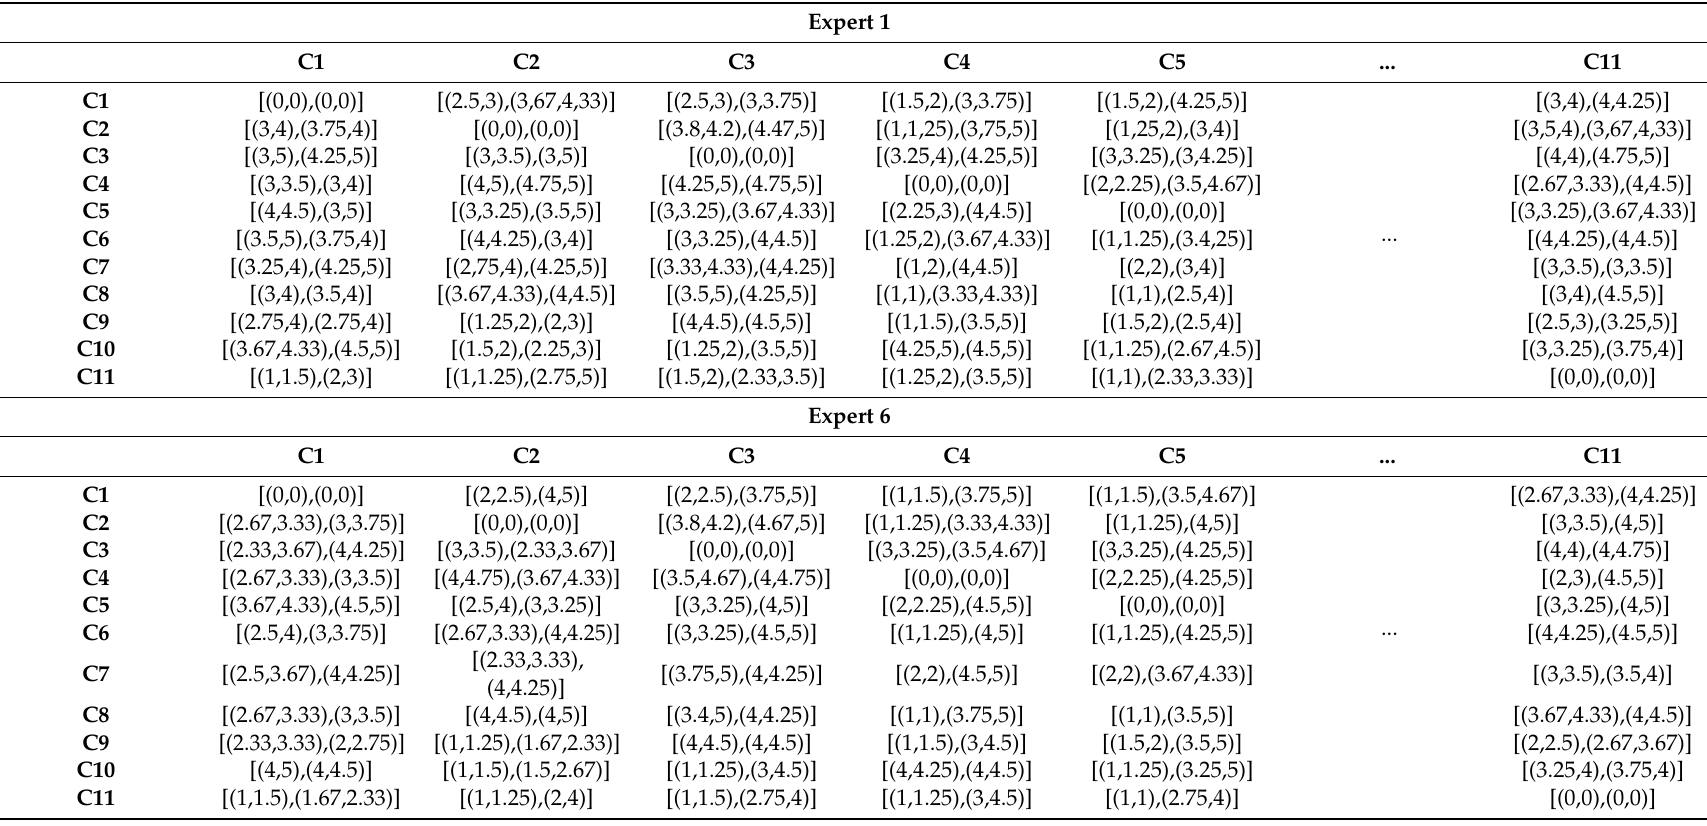
Table 4. Interval rough expert comparison matrix in the pairwise conditioning